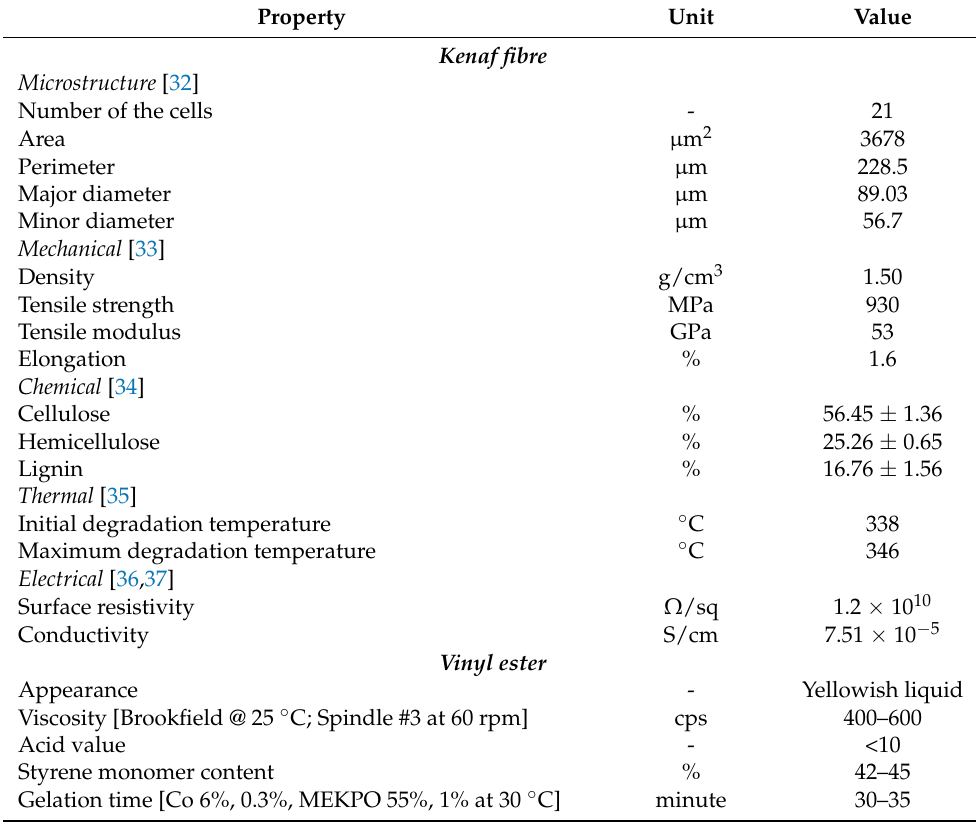
Table 1. The microstructure, mechanical, chemical, thermal, and electrical properties of kenaf fibre. Property Unit Value Kenaf fibre